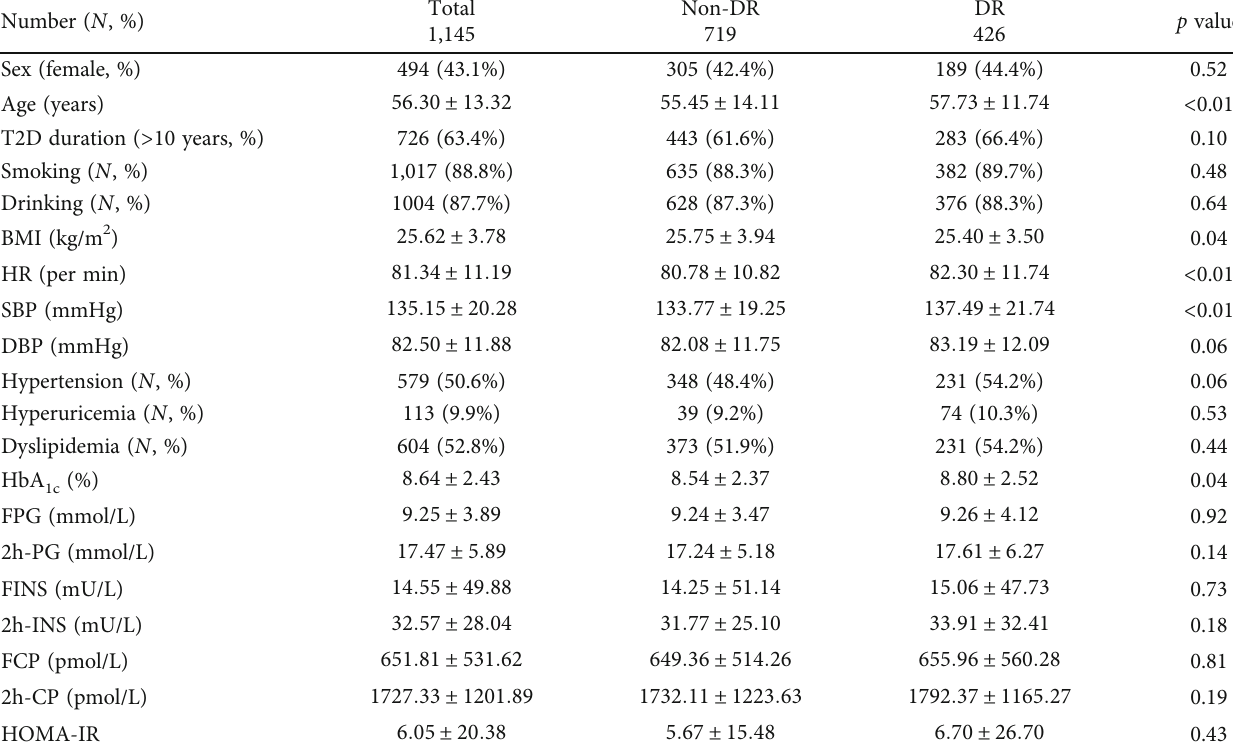
Table 1: General characteristics of participants strati fi ed by the presence of DR.